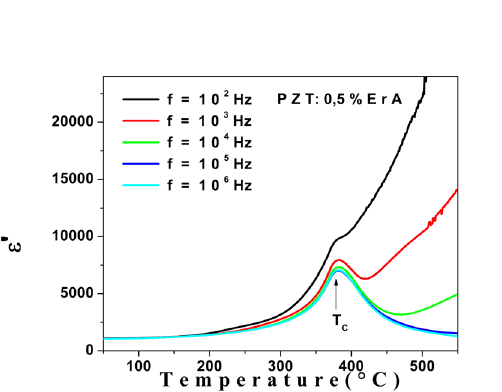
Figure 13. Dependence of dielectric constant with temperature and frequency for PZT: 0.5%ErA.